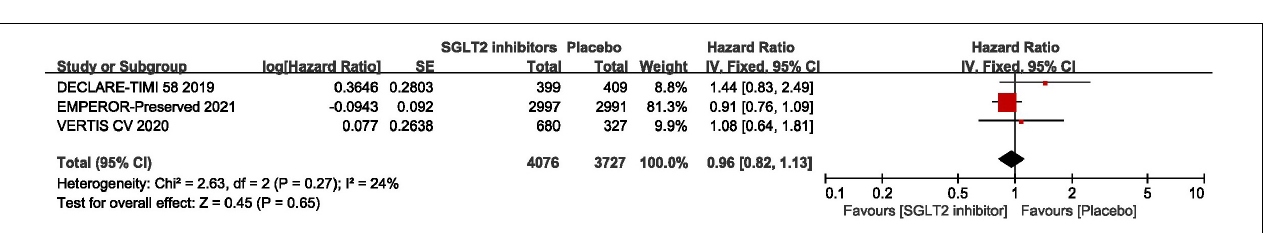
FIGURE 6 | Forest plot displaying the effects of SGLT2 inhibitors vs. placebo for first hospitalization for heart failure in HFpEF patients.